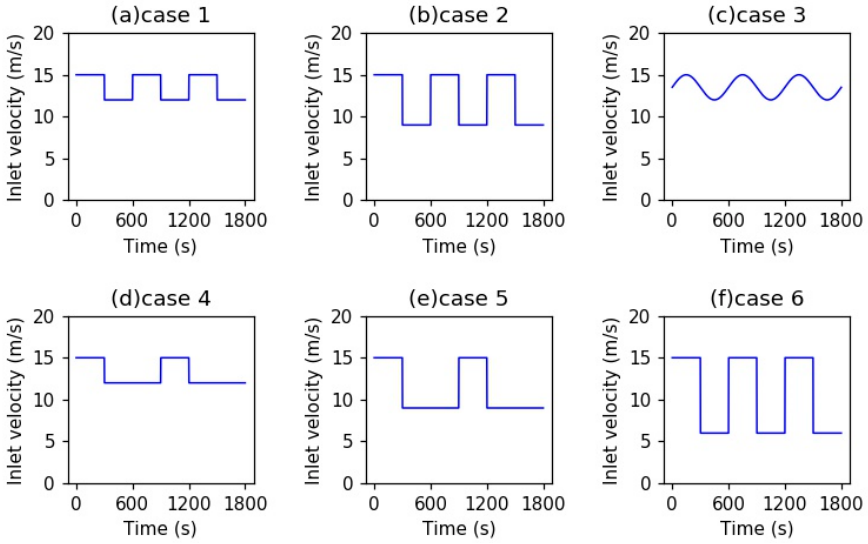
Figure 5. Six different ventilation patterns.